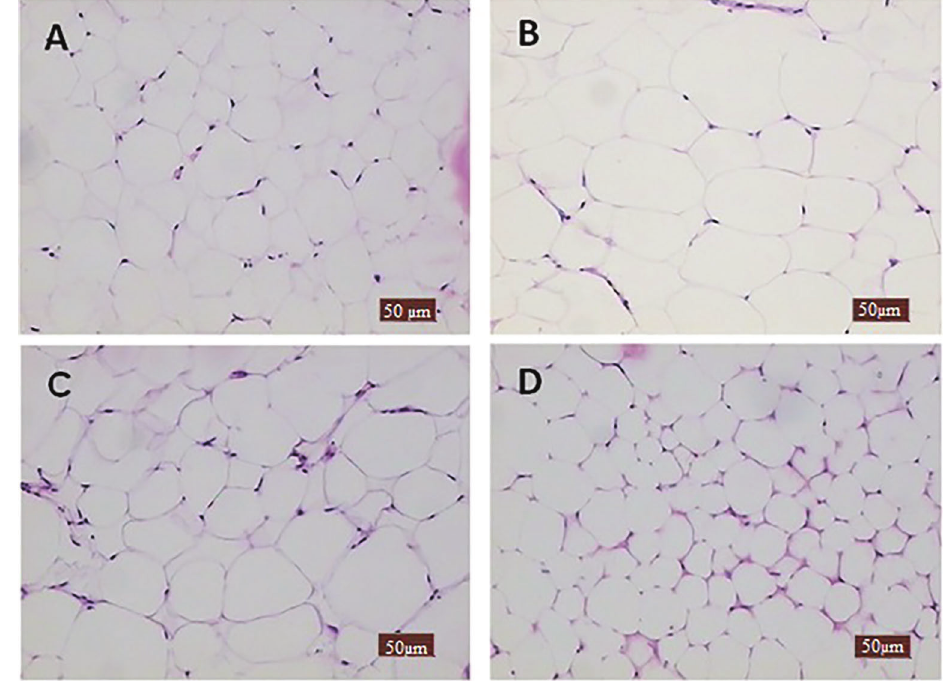
Figure 3. Histology of adipose tissue of mice fed the experimental diets for 15 weeks. Representative microphotographs of mouse epididymal fat pad ( A ), normal diet showing normal architecture of adipocytes ( B ), high-fat diet showing an increased size adipocyte ( C ), high-fat diet + ferulic acid treatment, and ( D ), high-fat diet + sibutramine treatment, which presents smaller adipocytes compared to normal diet-fed animals (H&E, (cid:1)